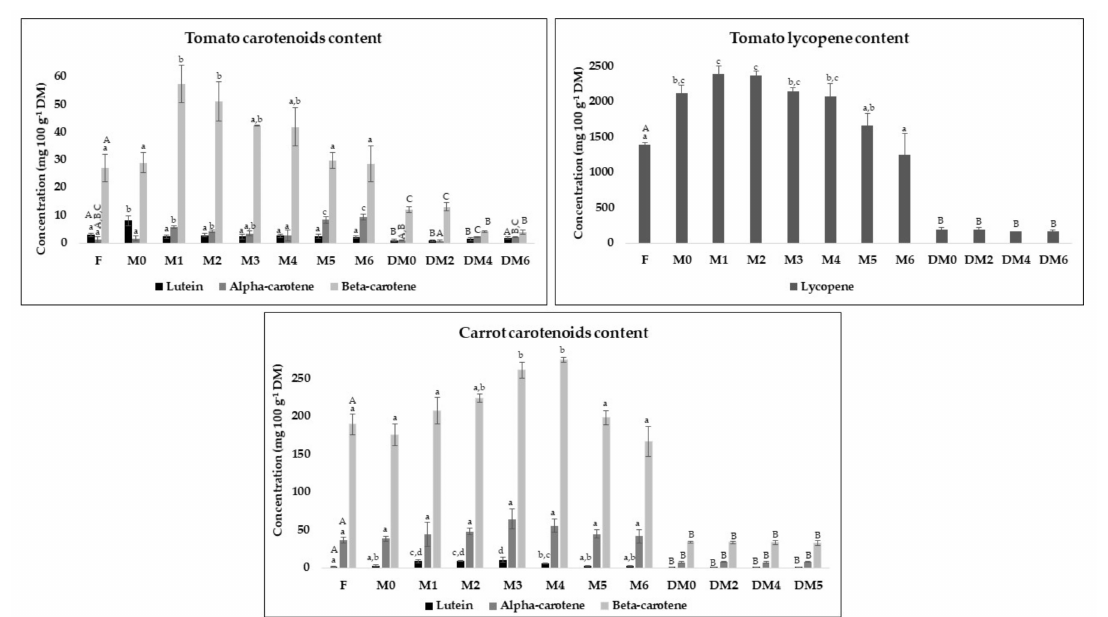
Figure 4. The concentration of carotenoids ( n = 3) detected in fresh carrot and tomato by-products and during the freezing and drying storage by HPLC-DAD at a wavelength of 454 nm. All results (mean ± standard deviation) were expressed in mg 100 g − 1 on a dry basis. Bars of the same color and corresponding to the same storage method with different superscript letters are significantly different ( p < 0.05). Lowercase letters were used for fresh and frozen pulps forms while uppercase letters were used for fresh and dry powders forms. M0 = 24 h after the freezing storage of pulps. M1, M2, M3, M4, M5, M6 = month one, two, three, four, five and six of the freezing storage of pulps, respectively; DM0 = day 0 of the powders storage. DM2, DM4, DM6 = month two, four and six of the storage period of